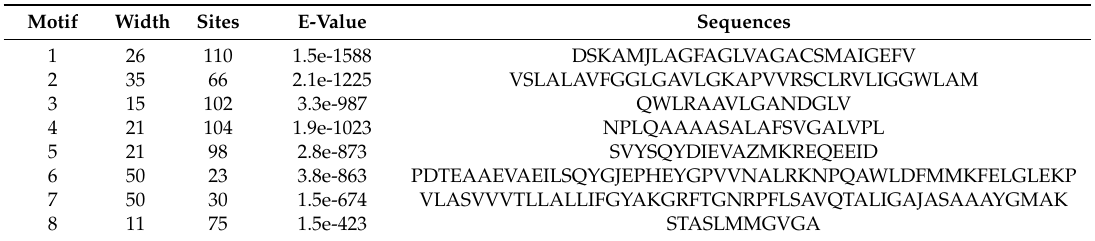
Table 1. Conserved motifs identified by Multiple Em for Motif Elicitation (MEME) among plant VIT